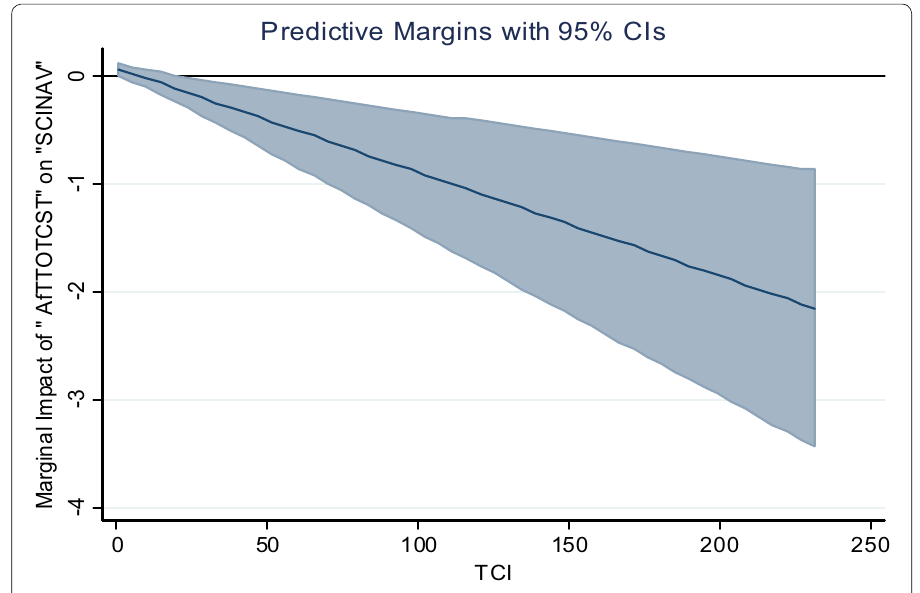
Fig. 5 Marginal impact of “AfTTOTCST” on “SCINAV”, for varying degrees of TCI (Source: